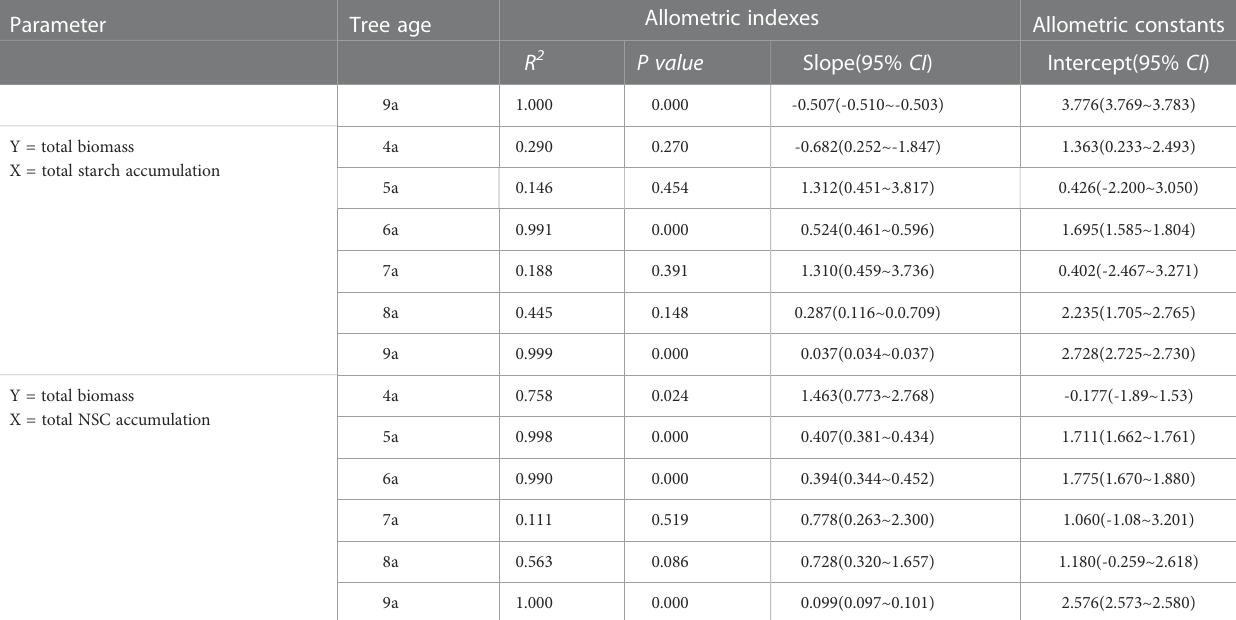
TABLE 7 The r coef fi cients of pearson correlations between individual yield (seed biomass) and the concentrations and accumulations of soluble sugar, starch, and NSC in each organ of Fengdan during dormancy/fruit ripening.